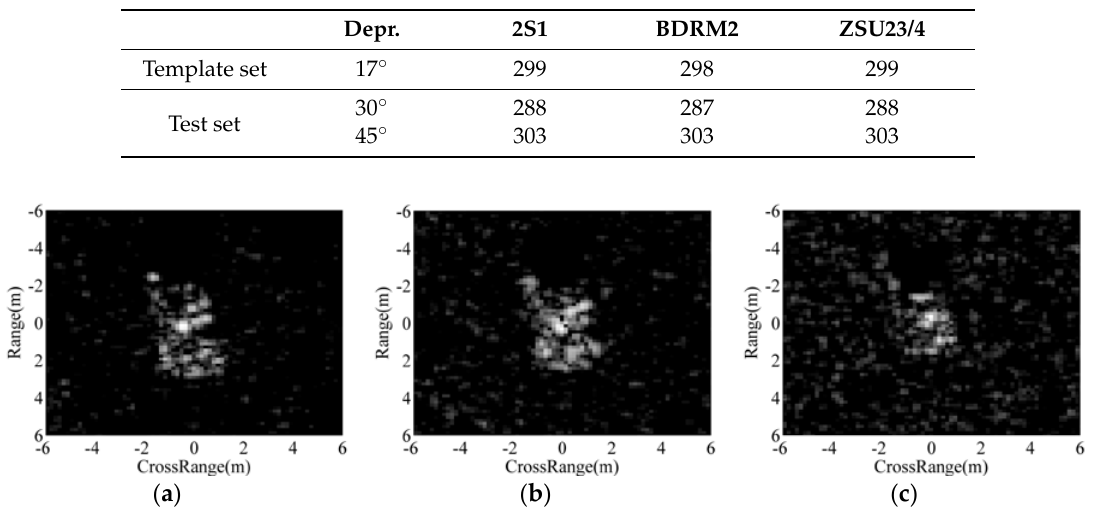
Figure 9. SAR images of 2S1 at different depression angles of ( a ) 17°; ( b ) 30°; ( c ) 45°. Table 9. Recognition results of the proposed method under large depression